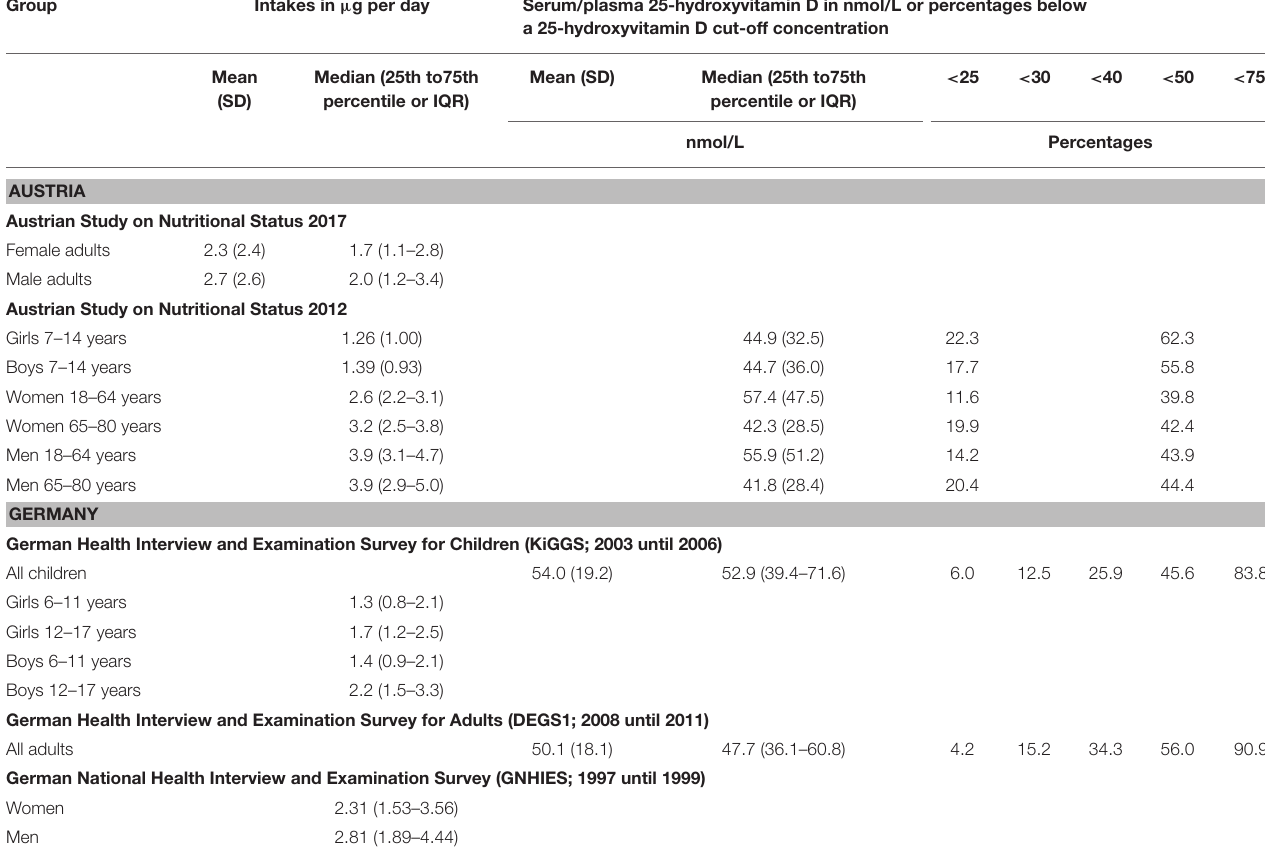
TABLE 4 | Vitamin D intakes and status in Austria and Germany.